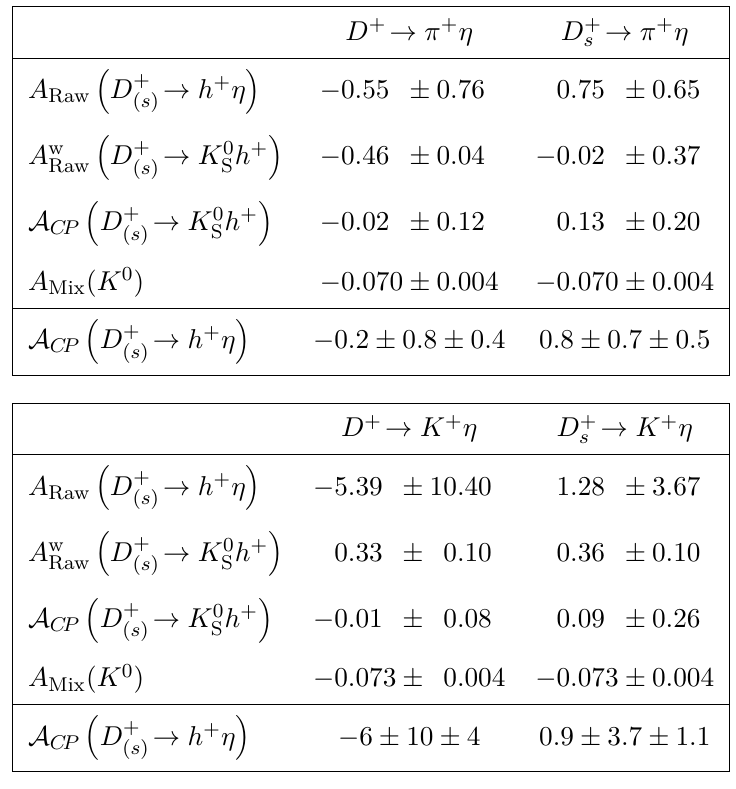
Table 6. Final A CP (%) results for the D + → h + η modes. The uncertainties of A CP ( D + → ( s ) ( s ) h + η ) are statistical and systematic respectively. The uncertainties of A Raw ( D + → h + η ) are ( s ) purely statistical. The uncertainties of A Mix ( K 0 ) are systematic. Externally measured values of A CP ( D + → K 0 h + ) are taken from refs. [18, 37–41]. For comparison the unweighted con- S ( s ) trol asymmetries are A Raw ( D + → K 0 π + ) = − 0 . 45 ± 0 . 02 , A Raw ( D + → K 0 π + ) = − 0 . 13 ± 0 . 17 , s S S A Raw ( D + → K 0 K + ) = 0 . 47 ± 0 . 05 and A Raw ( D + → K 0 K + ) = 0 . 51 ± 0 . 04 s S S